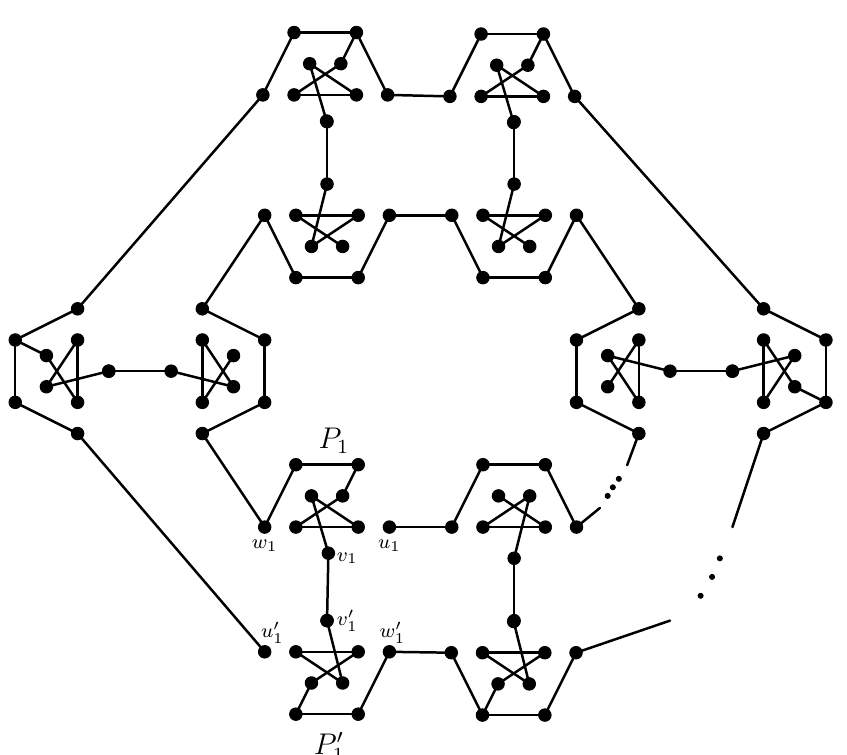
Figure 3: A spanning tree T of the cubic graph G in Figure